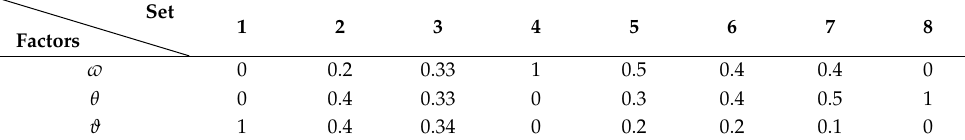
Table 3. Different values of (cid:118) , θ , ϑ .